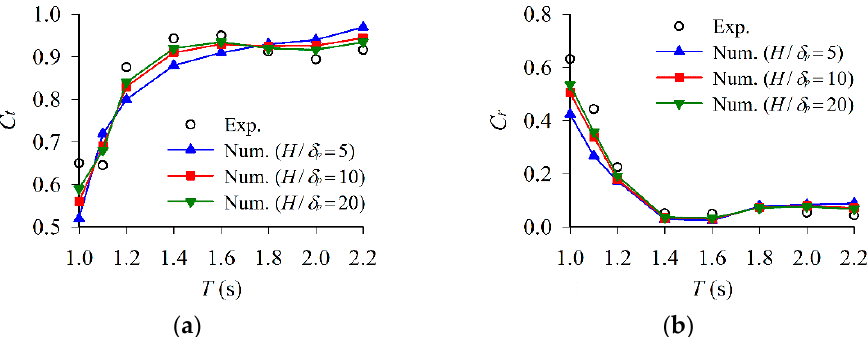
Figure 5. Comparison of the experimental and numerical wave transmission coefficients and re- flection coefficients of the cuboid floating pontoon: ( a ) Wave transmission coefficient C t ; ( b ) Wave reflection coefficient C r .